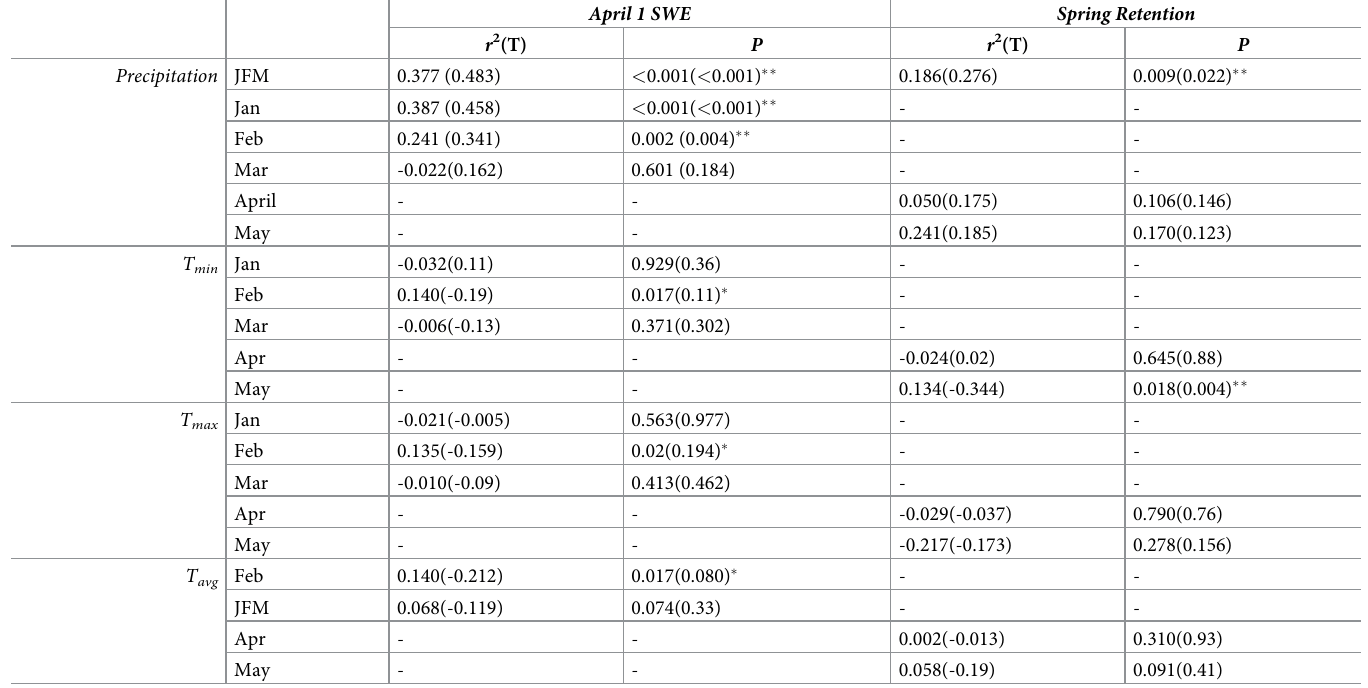
Table 2. Regression and Kendall correlation matrix values for Crown of the Continent temperature and precipitation metrics.